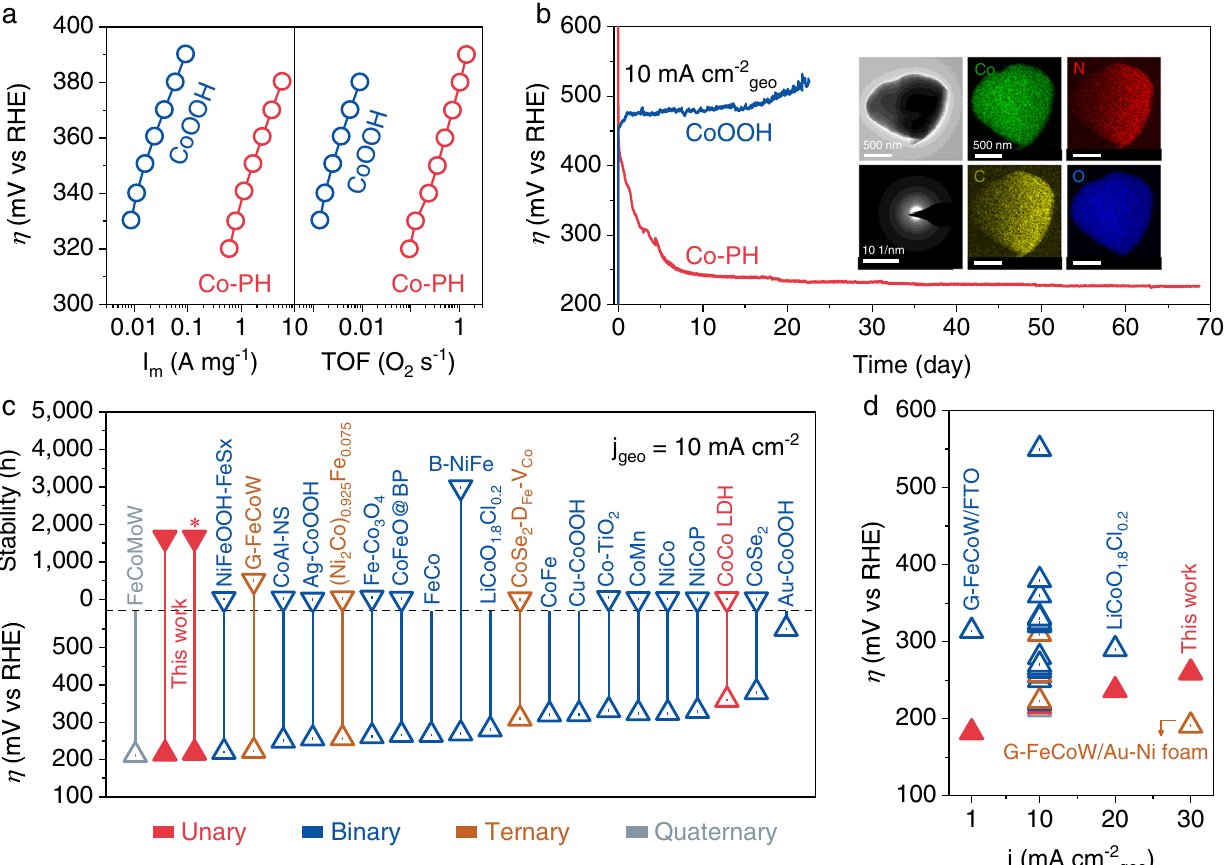
Fig. 6 |Phen-enrichedCo 4+ foref fi cient wateroxidation.a TafelplotsoftheOER mass activity and TOF of as-prepared CoOOH and electrodeposited Co-PH. Co-PH was freshly deposited in Co(phen) 2 (OH) 2 -containing 1.0M NaOH for 10min at 1.7 V RHE . b Stability tests of Co-PH and CoOOH at 10mAcm − 2 on planar FTO. The stability test of the as-prepared CoOOH was operated in 1.0M NaOH. Co-PH was insitudepositedonbareFTOanditsstabilitytestwasoperatedinCo(phen) 2 (OH) 2 - containing 1.0M NaOH. Insets: the TEM, SAED, and corresponding element